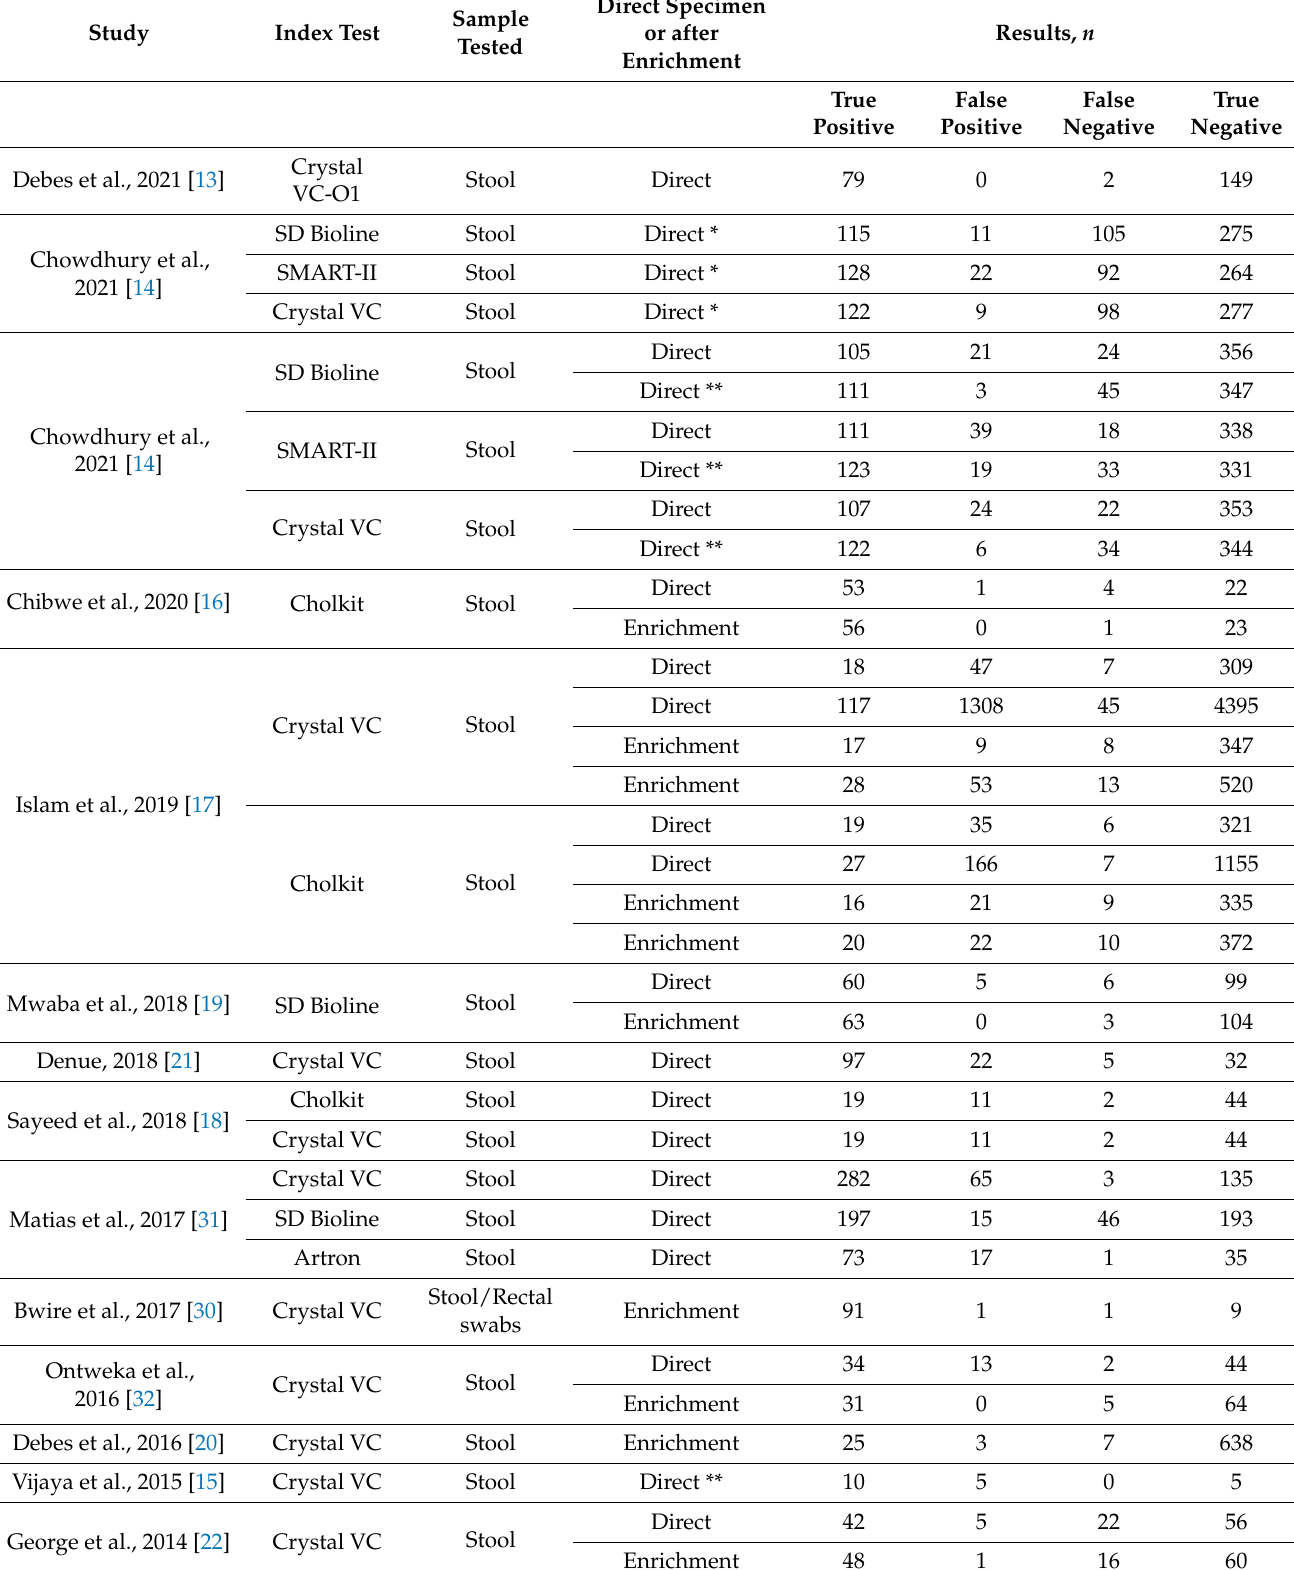
Table A2. Raw data extracted from studies included in the